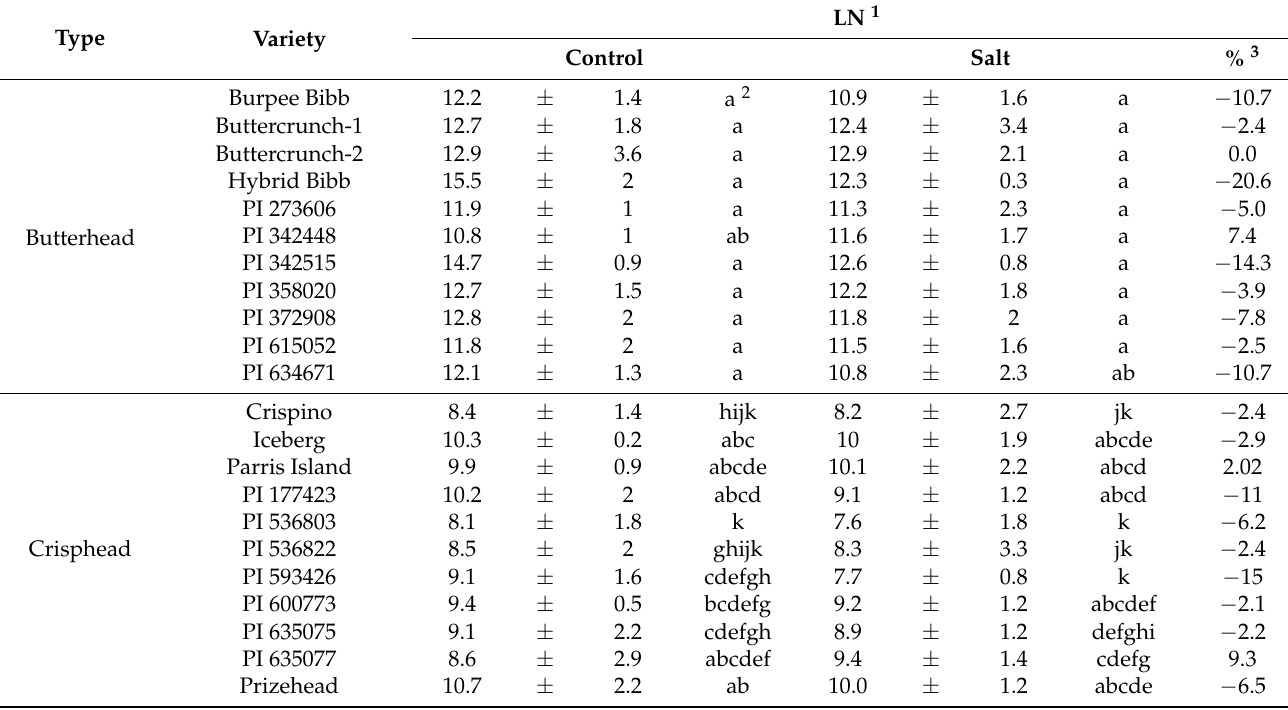
Table 1. Leaf number (LN) (mean ± standard deviation, n = 6) of butterhead- and crisphead-type lettuce cultivars grown under control and salt-stress conditions (100 mM) after 42 days of sowing (10 days after salt treatment).